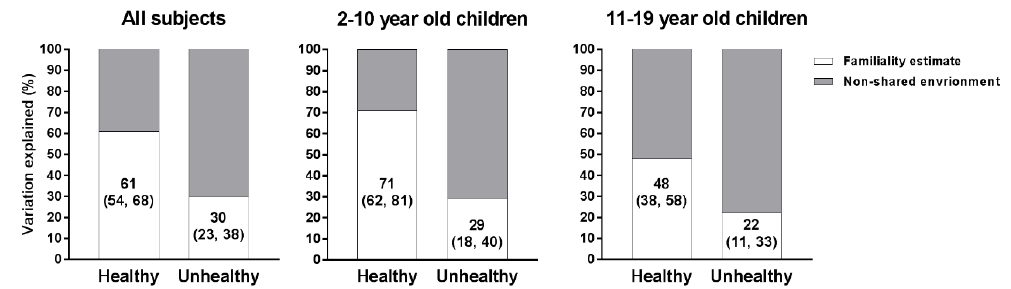
Figure 4. Porportion of variation for the sum of healthy and unhealthy food groups explained by familial and non-familial factors for all subjects and separately for younger and older children. The sample size consisted of 1435 families (746 families in the younger age group, and 760 families in the older age group).